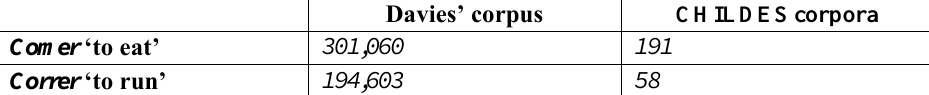
Table 3. Lexical frequency counts across lexical items and